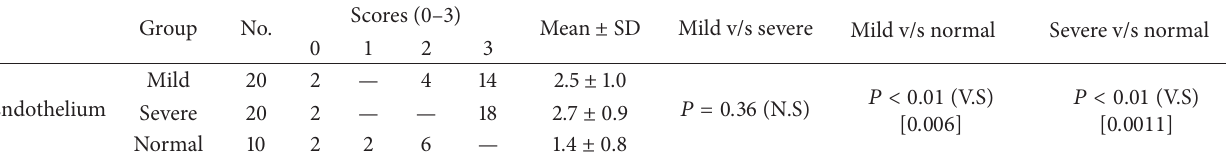
Normal Table 4: Pattern of vimentin scores of endothelium in mild OSF cases, severe OSF cases, and control group.